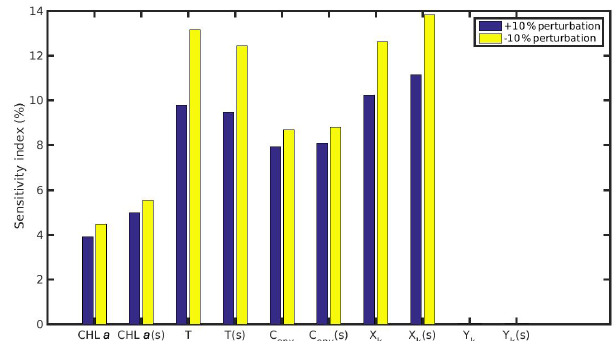
Figure 11. Sensitivity index of MPs accumulation for the wild mus- sel of the North Sea when variables (CHL a , temperature, C env ) and parameters ( X k ,Y k ) are perturbed ± 10%. The notation ( s ) refers to the permanently submerged mussel.